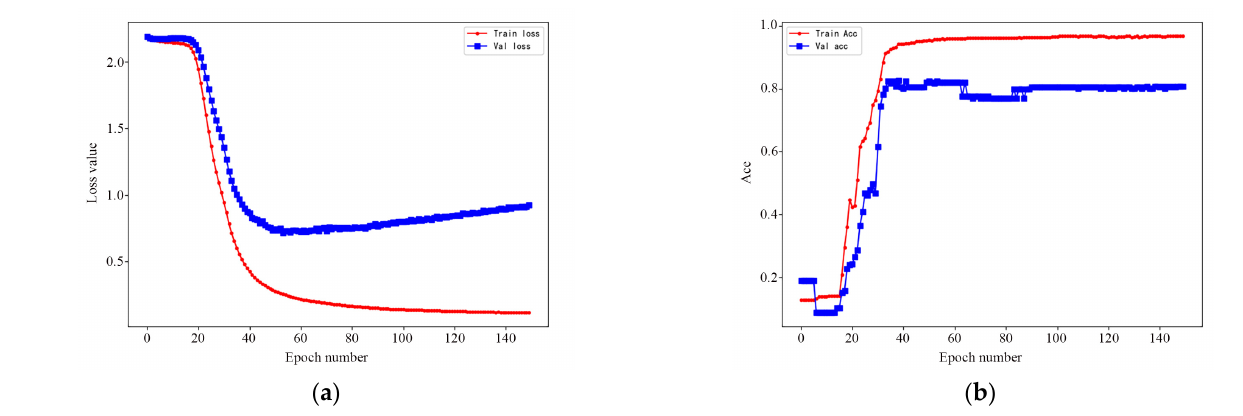
Figure 6. Training and testing efficiencies. ( a ) training efficiencies. ( b ) testing efficiencies. Table 4. Statistics of POI and landscape dominant function parcel.